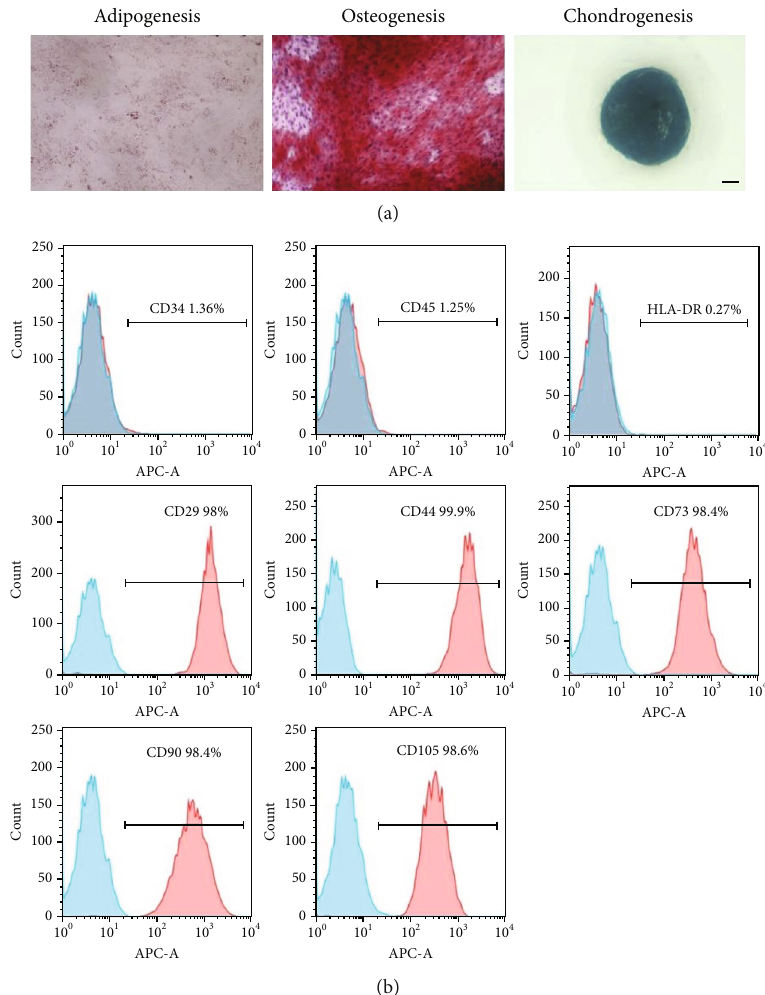
Figure 1: Characterization of hUC-MSCs. (a) Trilineage di ff erentiation of hUC-MSCs. Adipocyte di ff erentiation capacity of hUC-MSCs was con fi rmed by Oil Red O staining. Osteogenic di ff erentiation potential of hUC-MSCs was veri fi ed by Alizarin red staining. Chondrogenic di ff erentiation ability of hUC-MSCs was proved by Alcian blue staining. Scale bar = 1000 μ m. (b) Flow cytometry analysis of mesenchymal markers (CD34-, CD45-, HLA-DR-, CD29+, CD73+, CD90+, CD105+, and CD44+) and the corresponding isotype controls (mouse IgG1 Kappa, rat IgG2b Kappa, and mouse IgG2b